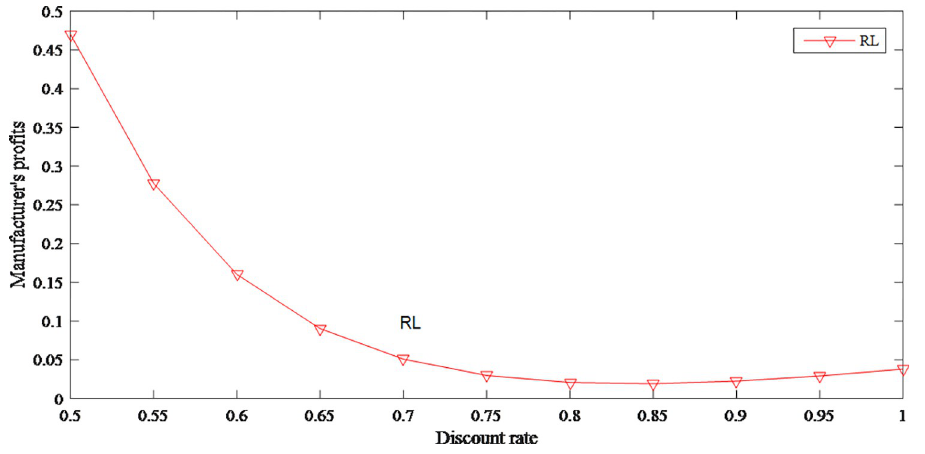
Fig 24. The impact of discount rate on manufacturer’s